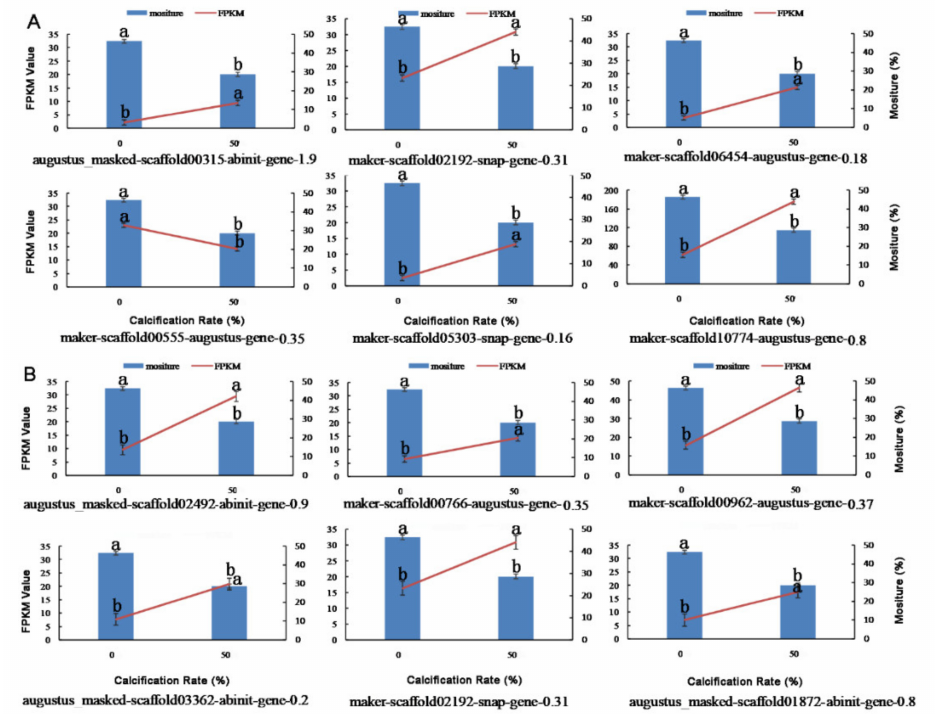
Figure 9. Relationship between the gene expression and the moisture content of chestnut calcification. ( A ) The differential expression genes (DEGs) in water transport (GO: 0006833) pathway; ( B ) the differential expression genes (DEGs) in response to water deprivation (GO: 0009414) pathway. Blue line: moisture content, red bars: transcriptomics RNA-seq analysis (FPKM). The letters (a,b) indicate significant differences ( p <